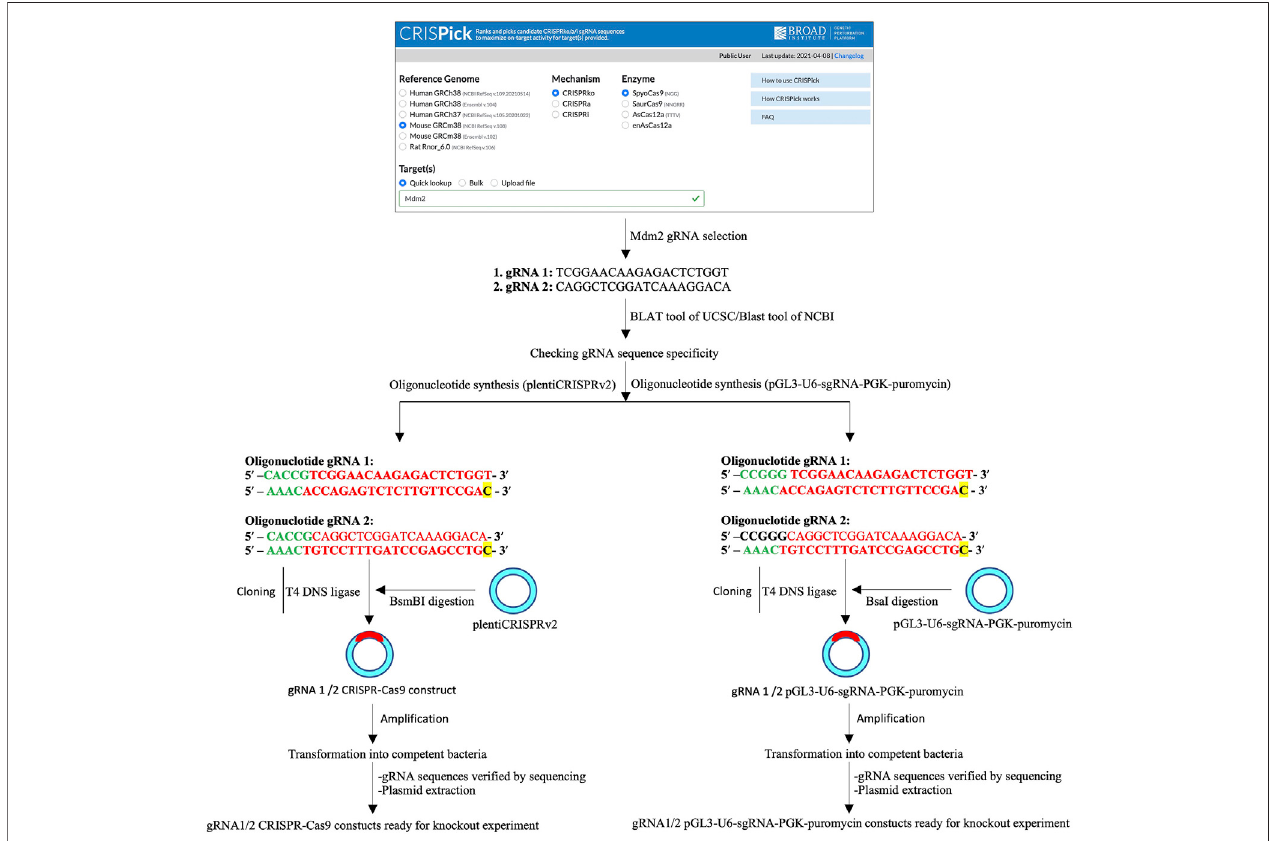
FIGURE 1 | Schematic of single- and two-vector construct preparation. A schematic of the single-guide RNA (sgRNA or gRNA) design, sgRNA primer synthesis, CRISPR/Cas9 (left) or pGL3-U6-sgRNA-PGK-puromycin (right) digestion and ligation of the sgRNA insert, and bacteria-based cloning of CRISPR/Cas9-sgRNA (left) or pGL3-U6-sgRNA-PGK-puromycin-sgRNA (right)